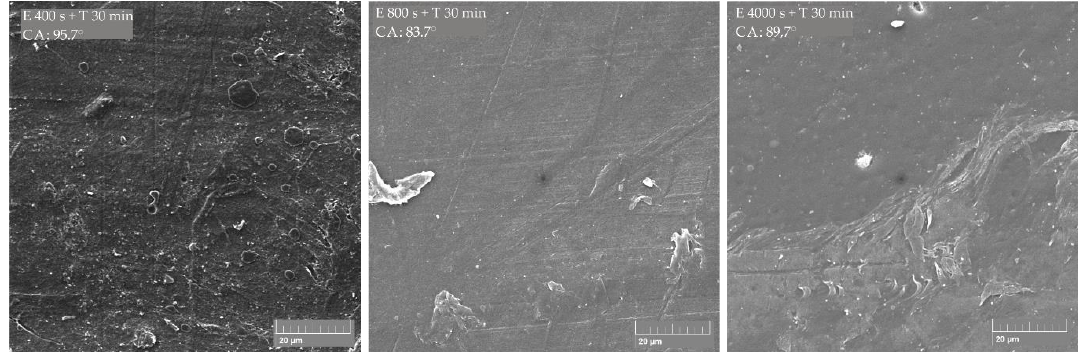
Figure 11. SEM micrographs of untreated ABS/PE-LD 90/10 polymer blend and treated by etching (E) and CF x coating (T); measured contact angle is indicated as CA.